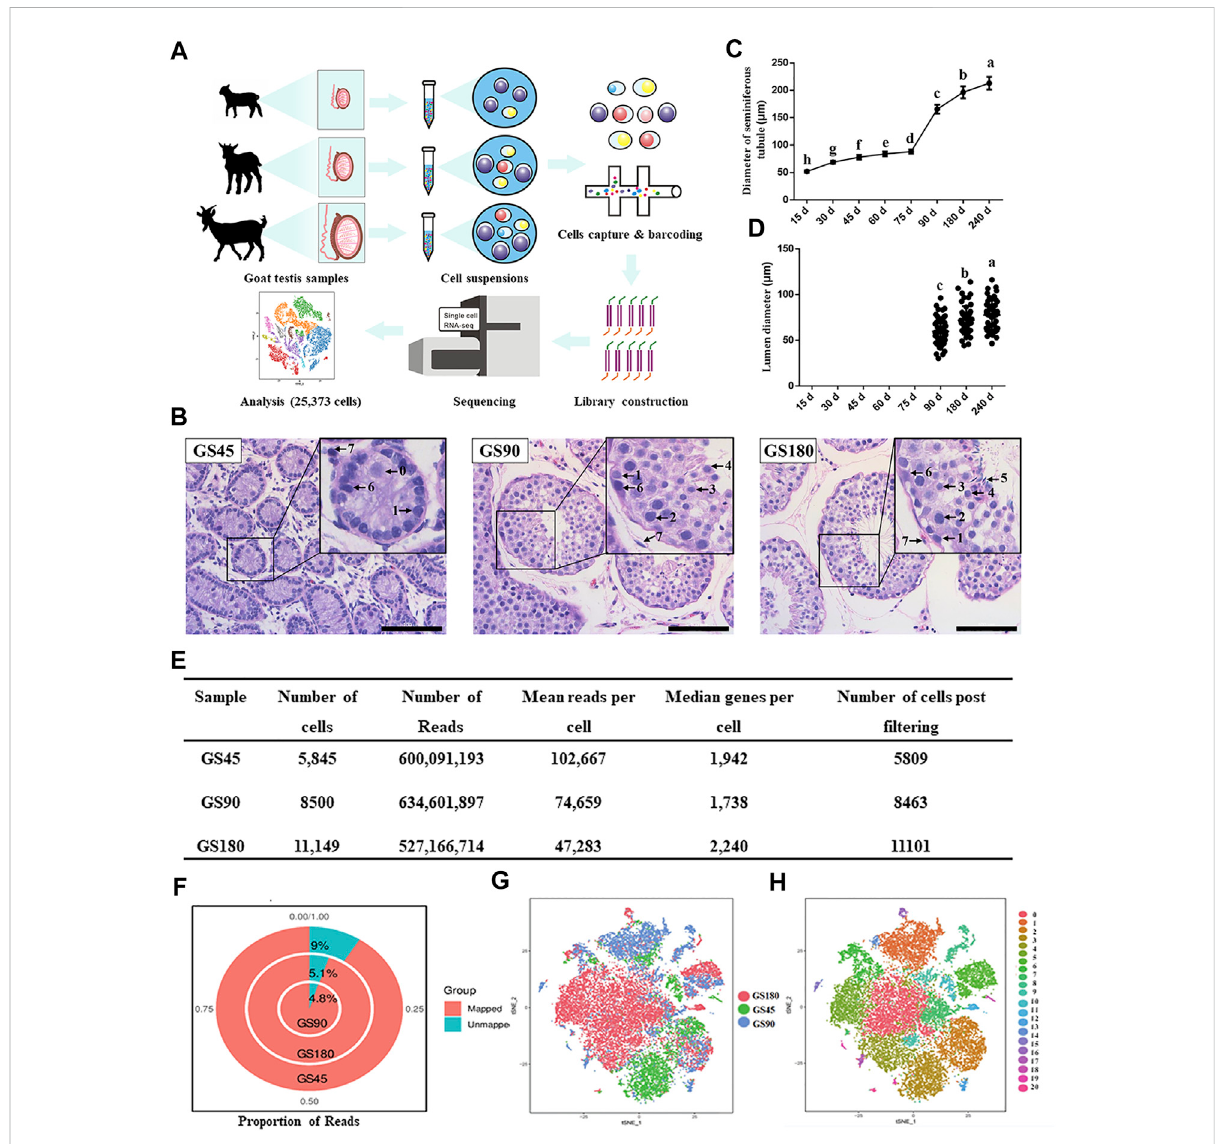
FIGURE 1 Overview of scRNA-seq in dairy goat testicular cells. (A) The single-cell RNA-seq process of dairy goat testicular cells. (B) Histomorphological analysis of dairy goat testes at different ages. 0, gonocyte. 1, spermatogonia. 2, early spermatocytes. 3, spermatocytes. 4, round spermatids. 5, elongated spermatids. 6, Sertoli cells. 7, Leydig cells. Bar = 100 μ M. (C) Variation in the diameter of the seminiferous tubule of dairy goat testes. (D) Variation in the diameter of the lumen of the seminiferous tubule of dairy goat testes. (E) Single cell datasets quality metrics summary identi fi ed byCellRanger. (F) Thereadsmappedtogenomeofthreesamples. (G) SampledistributionresultrevealedinthetSNEplot. (H) Cellclusteringrevealed in the tSNE